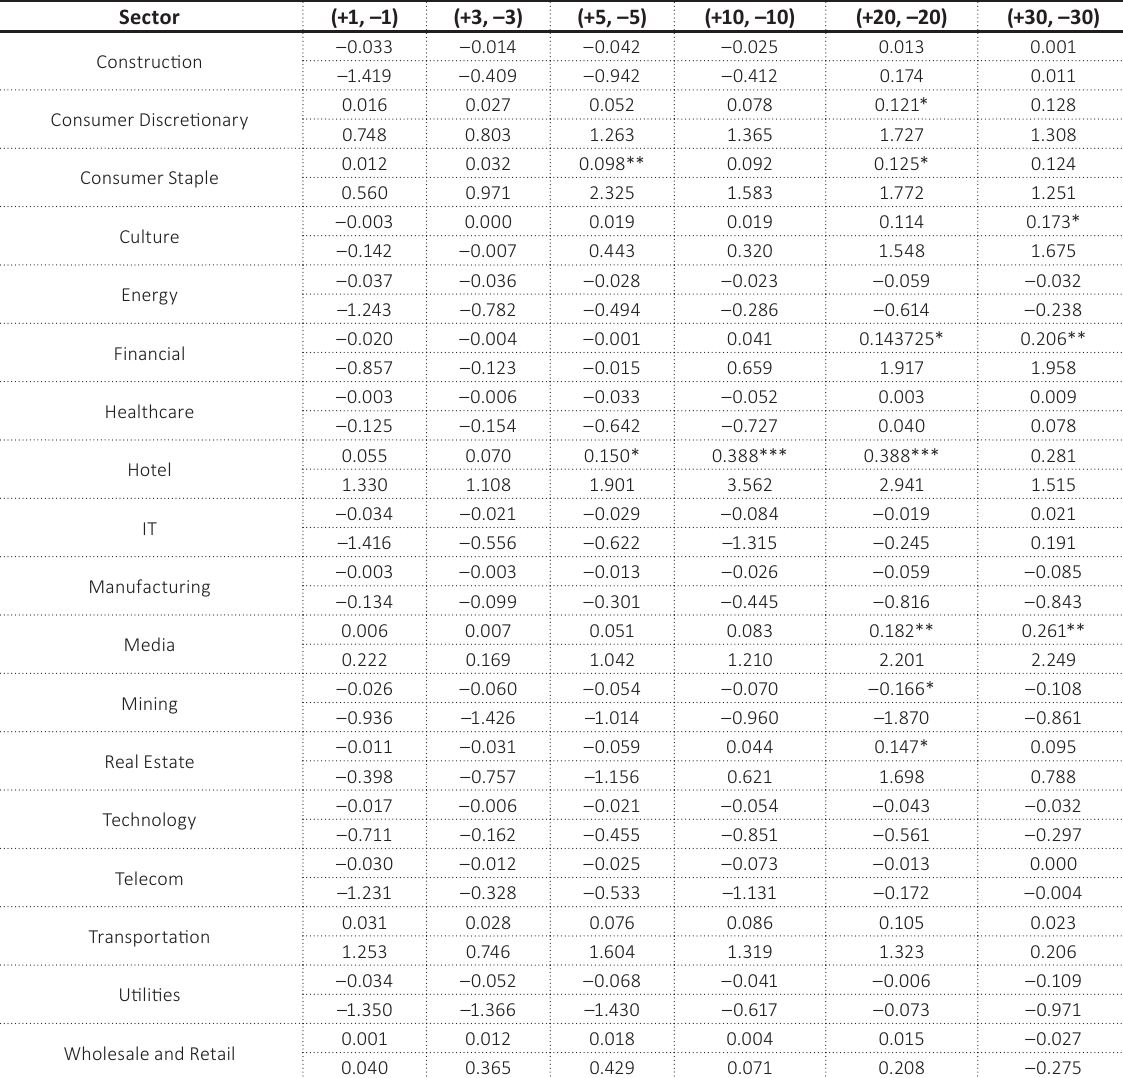
Table 2. Abnormal returns and t-statistics of different sectors of China pre-event to post-event windows (withdrawal of zero-COVID